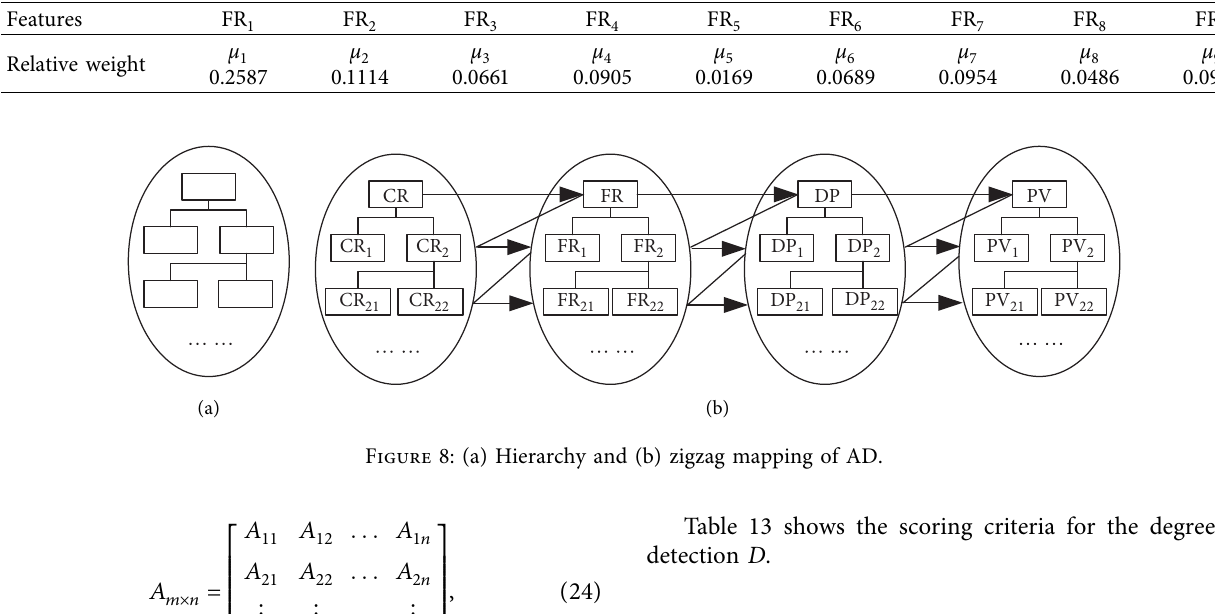
Table 9: Relative importance of system functional characteristics.